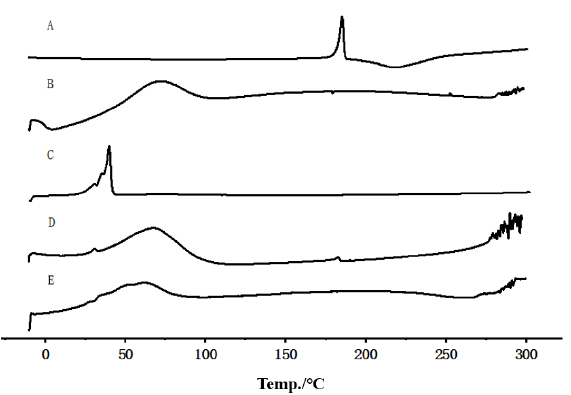
Figure 5. DSC thermograms of PPD ( A ), Soluplus ® ( B ), TPGS ( C ), physical mixture ( D ) and lyophilizates of PPD-S/T-MM-2.0 ( E ).